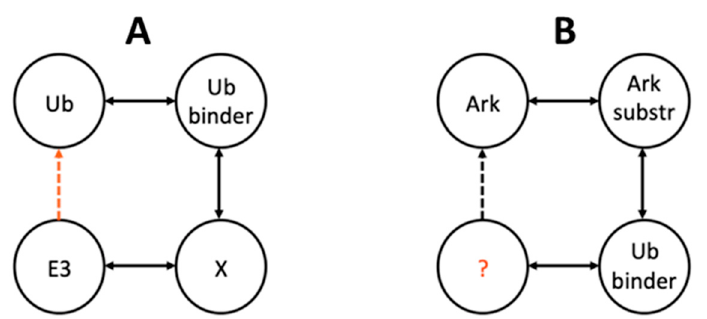
Figure 3. Illustration of the ℓ = 3 network-based approach used to identify ( A ) potential E3 RING ligases with Ub docking sites and ( B ) putative Ark and Ark2C interactors. In each case, the element under question is presented in red.